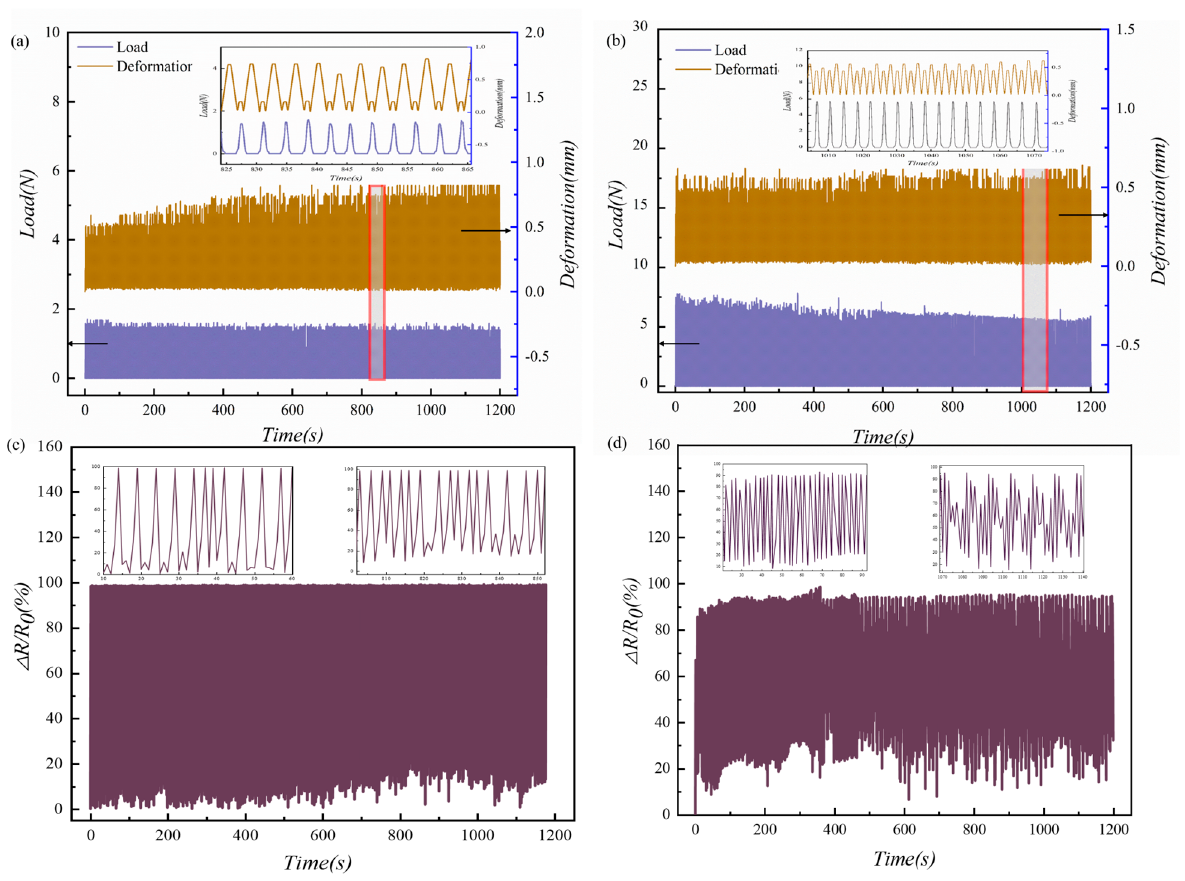
Figure 10. Cyclic loading experiment results of the presented flexible pressure sensors: Model − A cyclically loaded with ( a ) 0–1 N and ( b ) 0–5 N; piezoresistive response curves of ( c ) Model − A and ( d ) Model-E at 0–10 kPa under cyclic